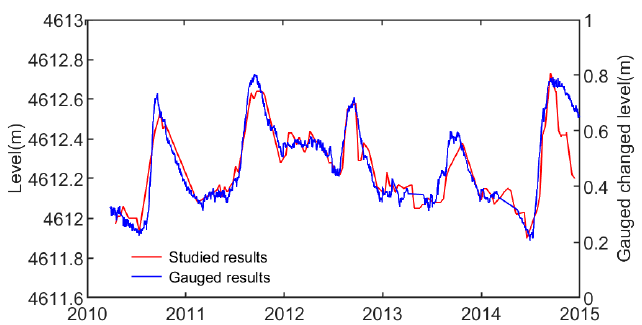
Figure 7. Comparisons between studied results and gauged records of Zhari-namco.